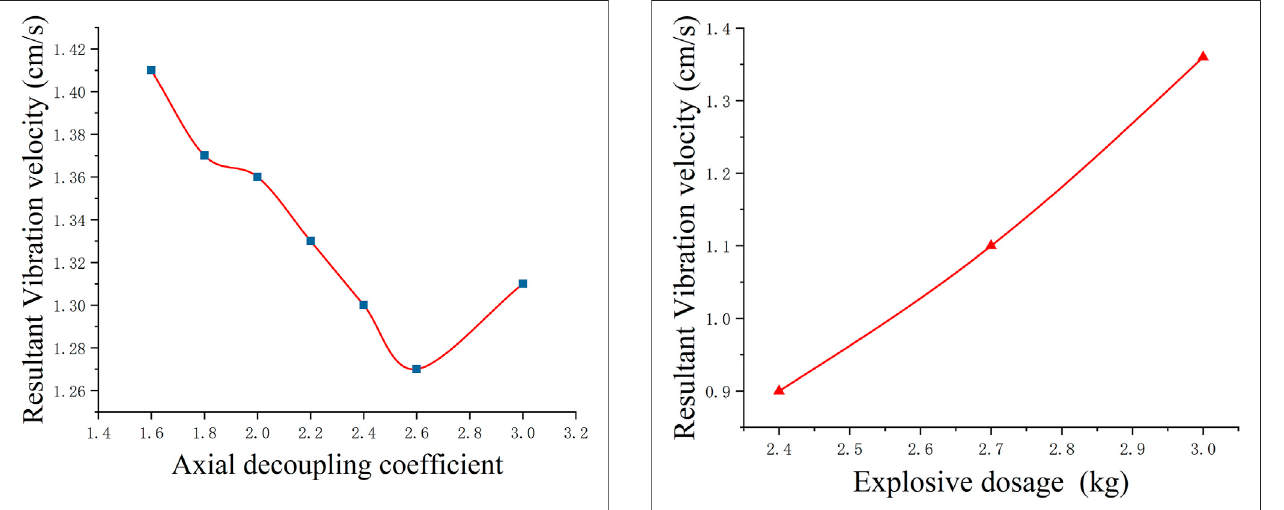
FIGURE 13 | The peak resultant vibration velocity response of Line 3 under different explosive